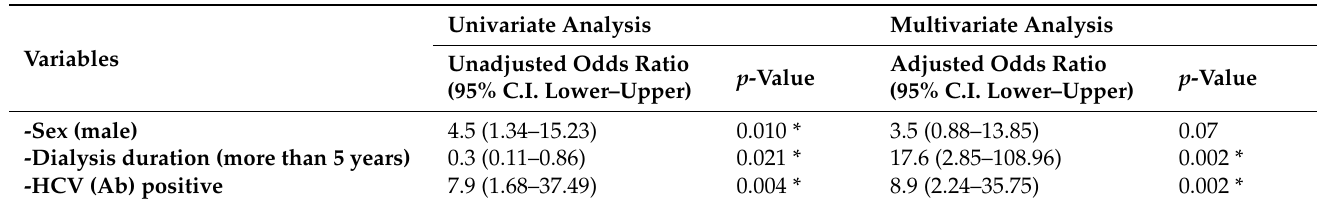
Table 4. Multivariate analysis of some demographic and clinical data predictors for no or inadequate response to hepatitis B